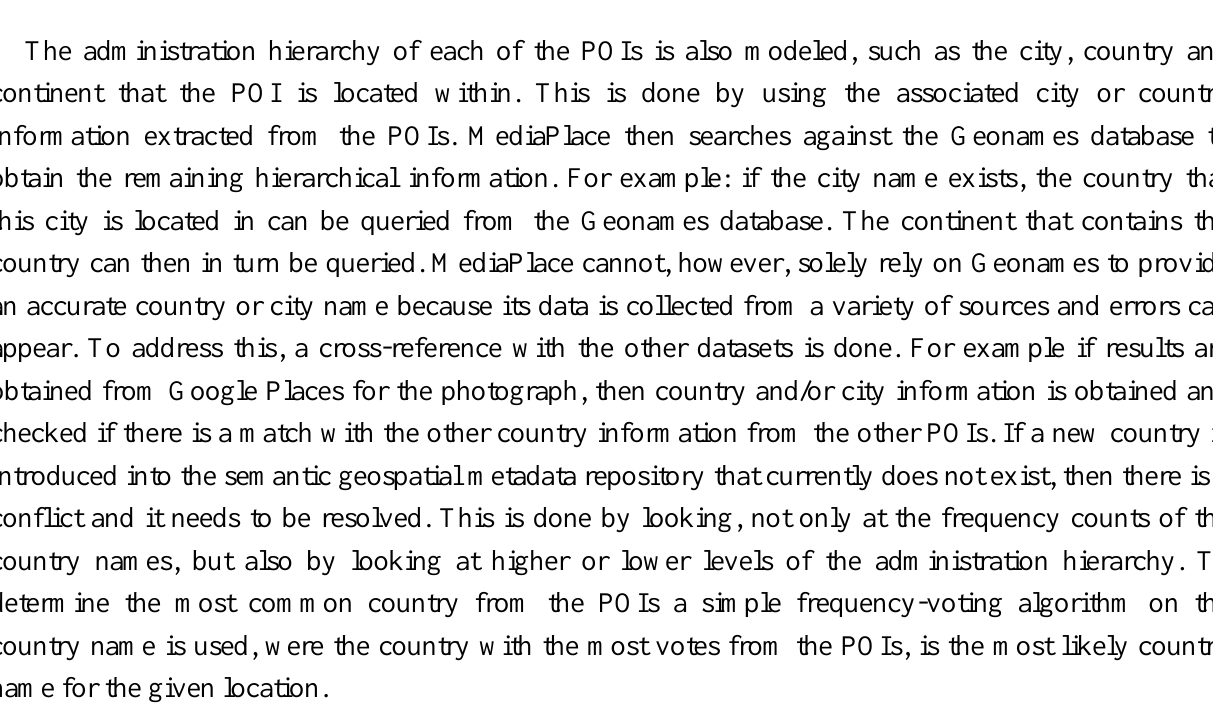
Figure 3. Snippet of RDF, for a POI, created by MediaPlace. The 256 bit SHA hash has been abbreviated for improved presentation